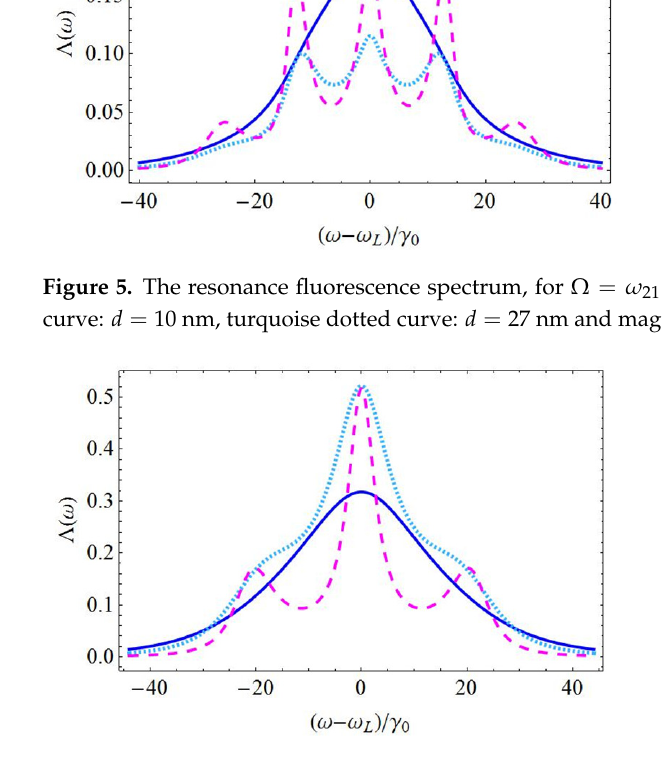
15 γΩ = , 0 ω = and 0 Δ = . Blue solid 0 21